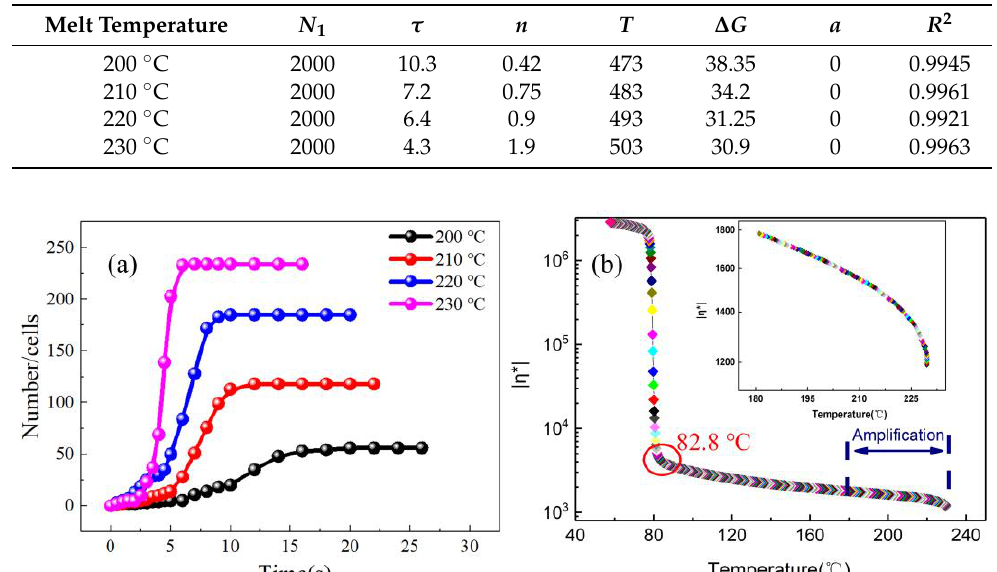
Table 3. Influence of melt temperature on the parameters.